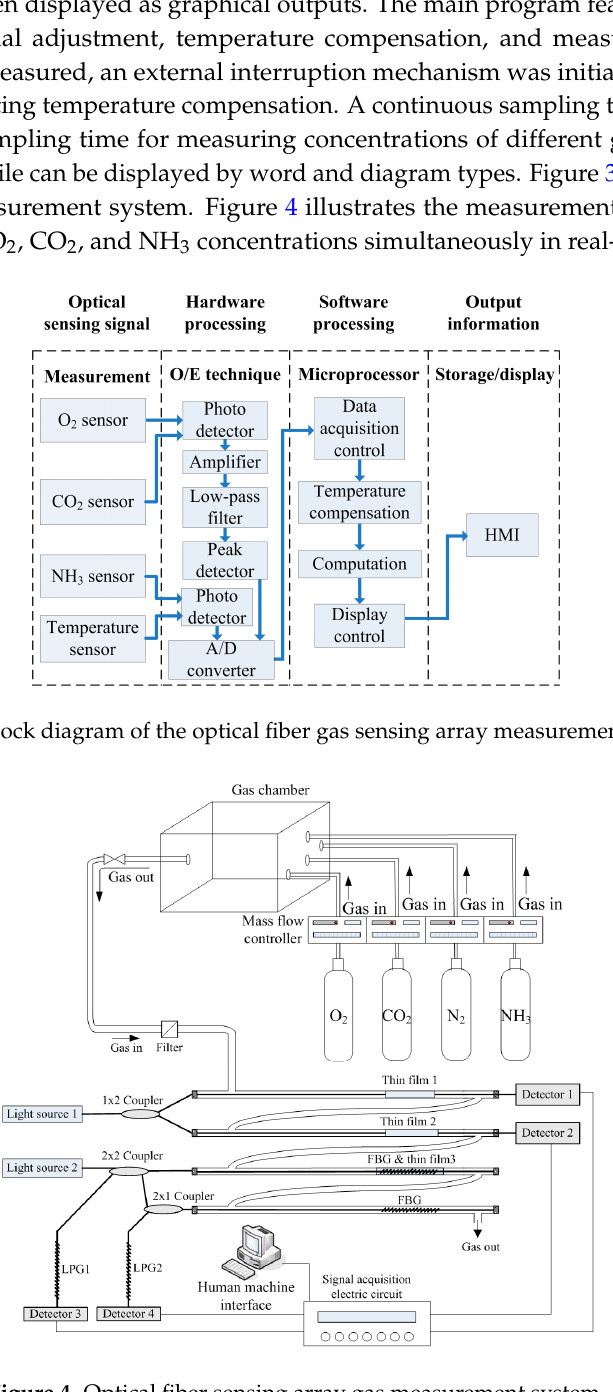
Figure 4. Optical fiber sensing array gas measurement system.